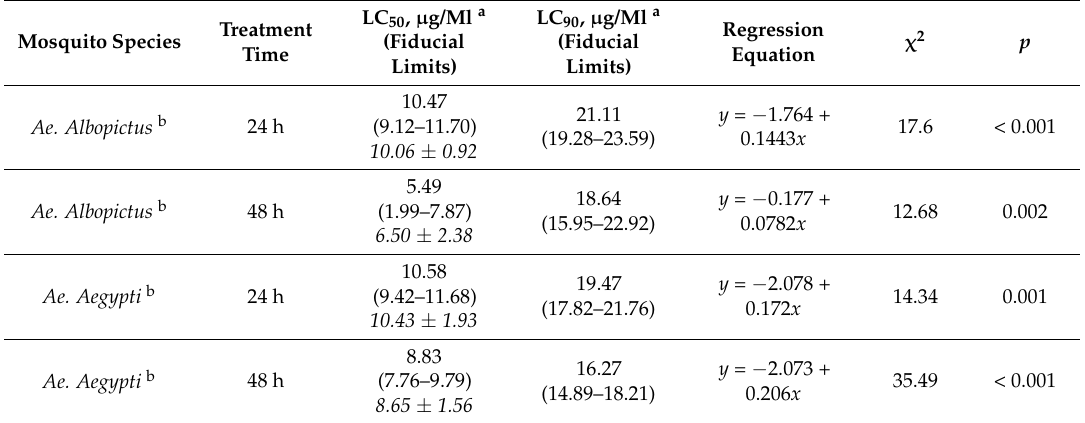
Table 4. Mosquito larvicidal activity of Erechtites hieraciifolius aerial parts (leaves and stems) essential oil. Mosquito Species